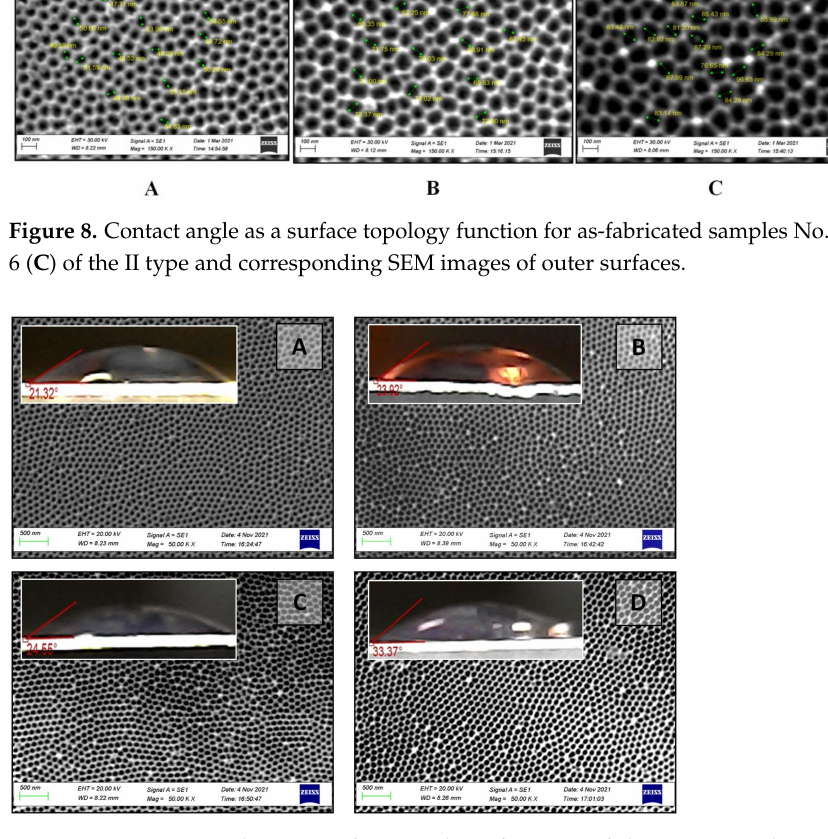
Figure 9. Contact angle as a surface topology function of the PAA sample No.5 of the II type after chemical modification in 5% H3PO4 for 5 min ( A ), 10 min ( B ), 15 min ( C ), 20 min ( D ), and corresponding outer surface SEM